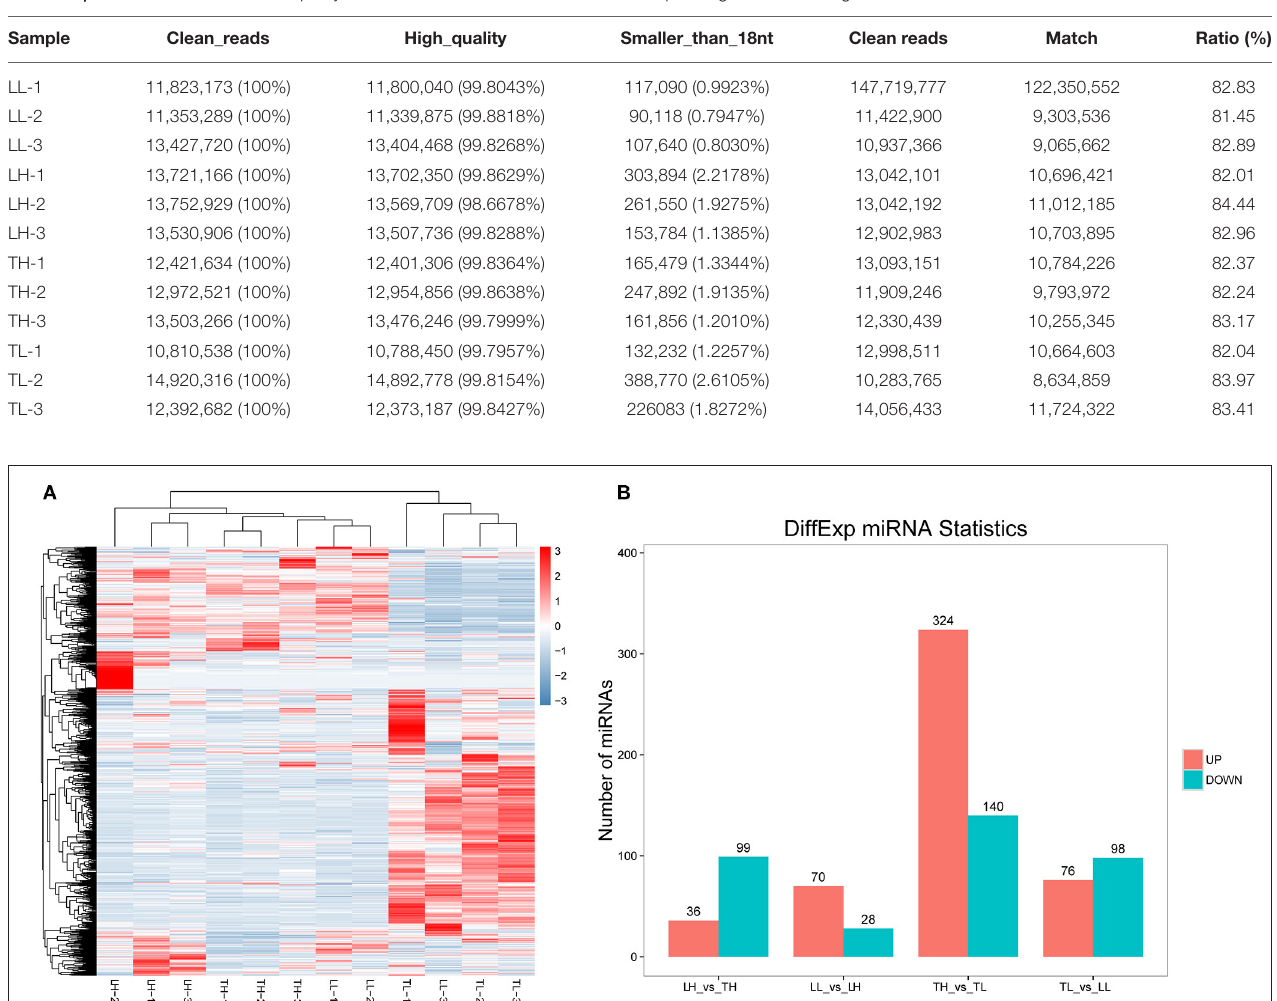
FIGURE 3 | miRNA expression results among the four groups by RNA-seq. (A) The heatmap shows the relative expression patterns of DEmiRNAs among the four groups. Each column represents a sample, and each row represents the expression levels of a single miRNA in various samples. The color scale of the heat map ranges from blue (low expression) to red (high expression). (B) The histogram shows the number of DEmiRNAs identified among the four